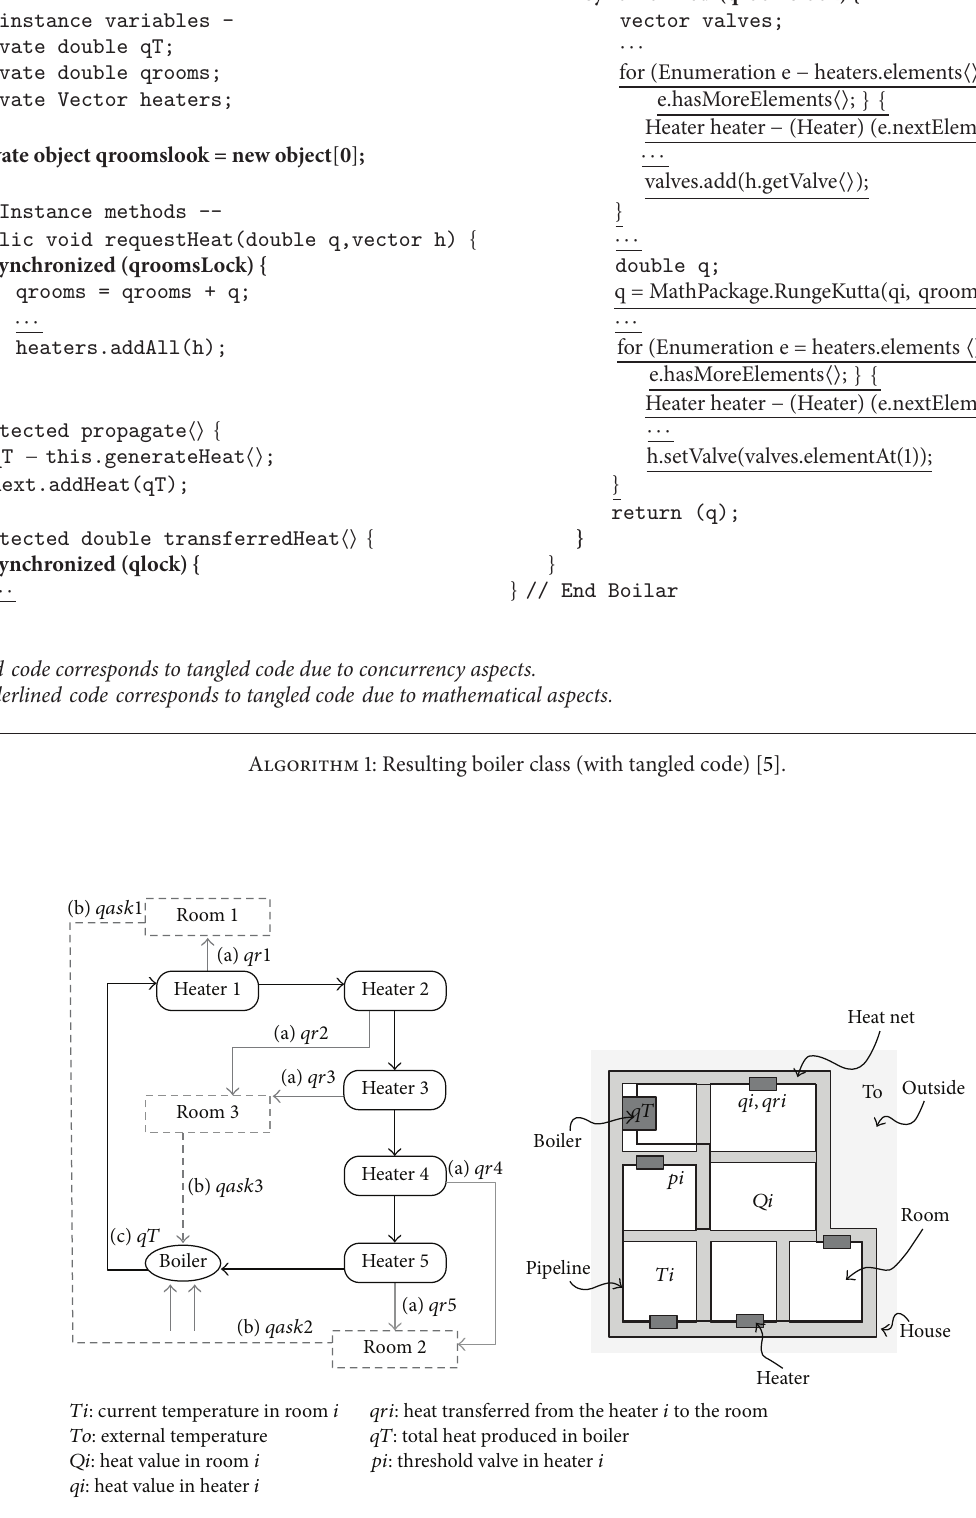
Figure 1: Diagram of the thermic control system